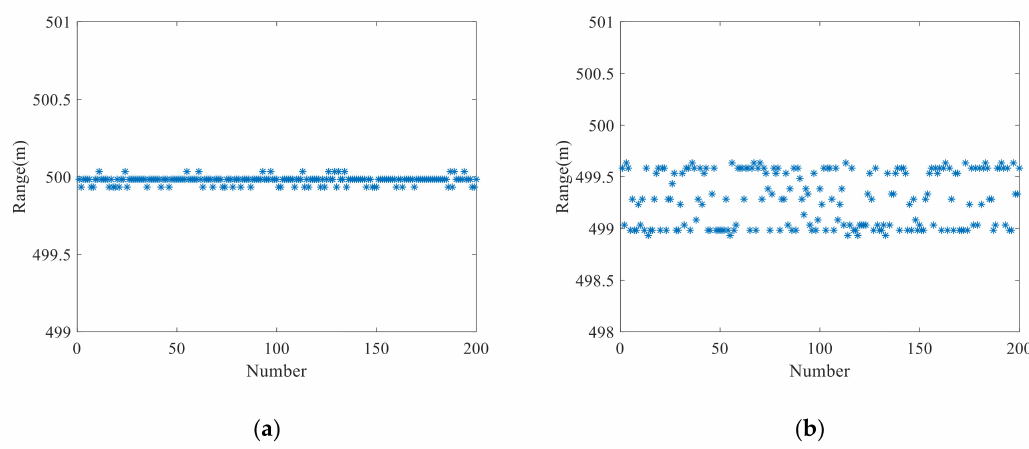
Figure 7. ( a ) One-dimensional range distributions after compensating for the primary vibration errors by using the proposed method; ( b ) One-dimensional range distributions by using the Doppler frequency shift method; ( c ) Phase distributions in the up and down observations of the three-point